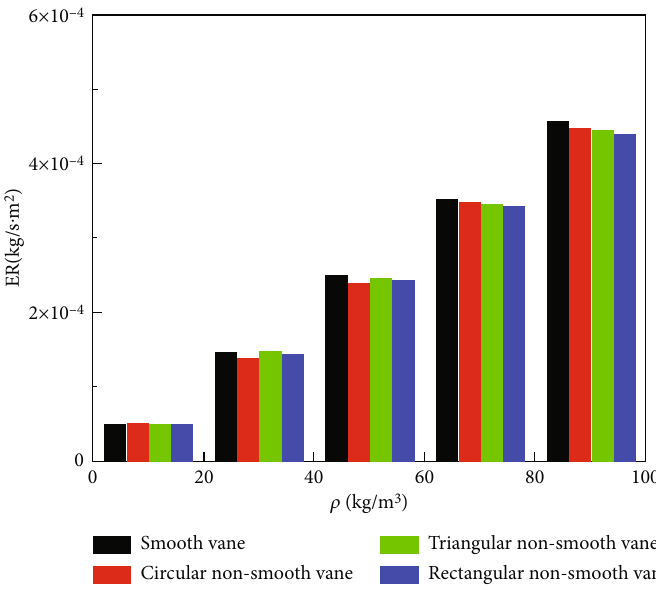
Figure 9: Average wear rate of worm shell at di ff erent vanes — particle concentration